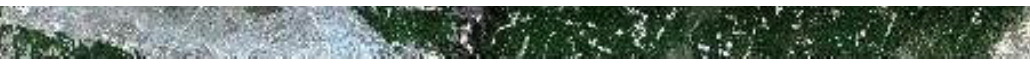
Figure 1. Compact airborne spectrographic imager (CASI) (122642) flight strip image of the Heihe River Basin.